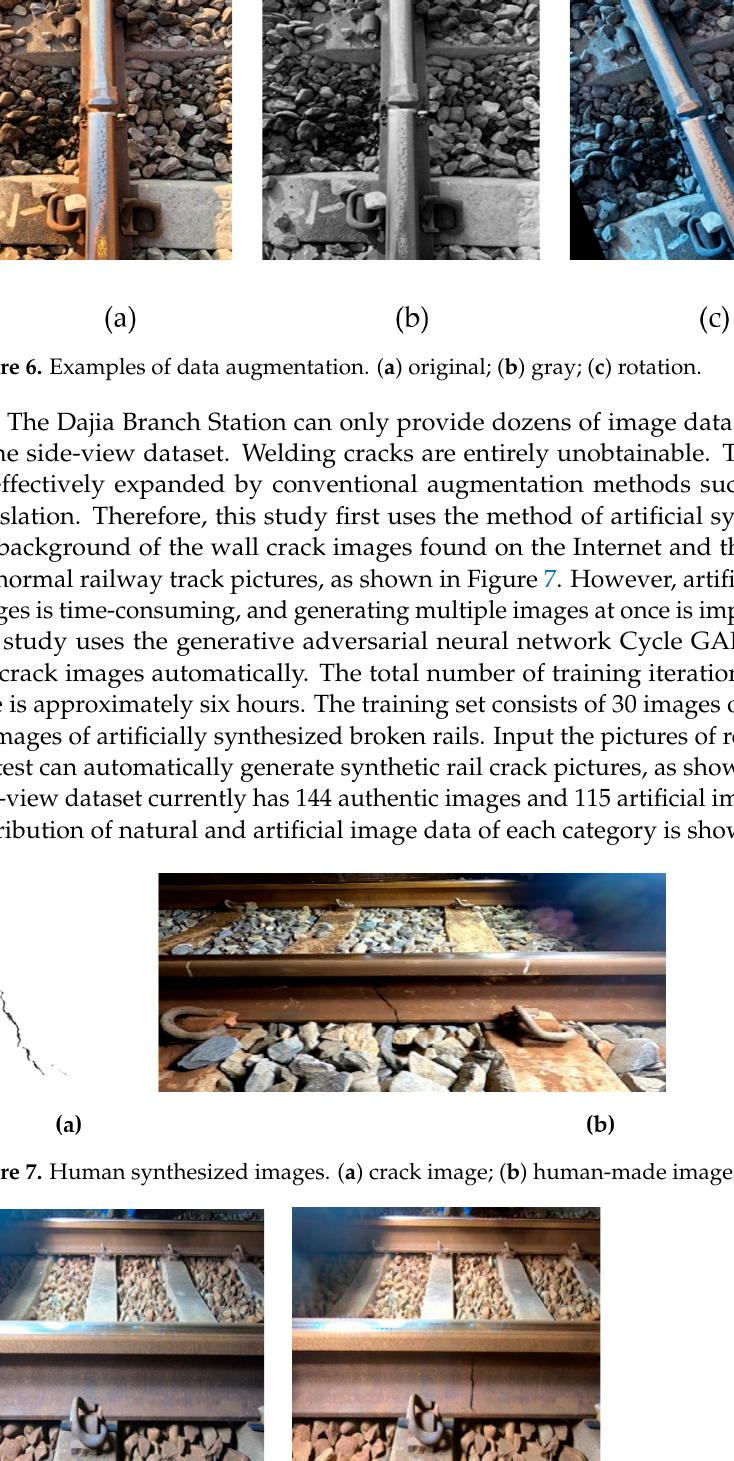
Figure 8. Automatic image generation. ( a ) original image; ( b ) cycle GAN-generated images. Table 6. The augmented s ide ‐ view dataset.